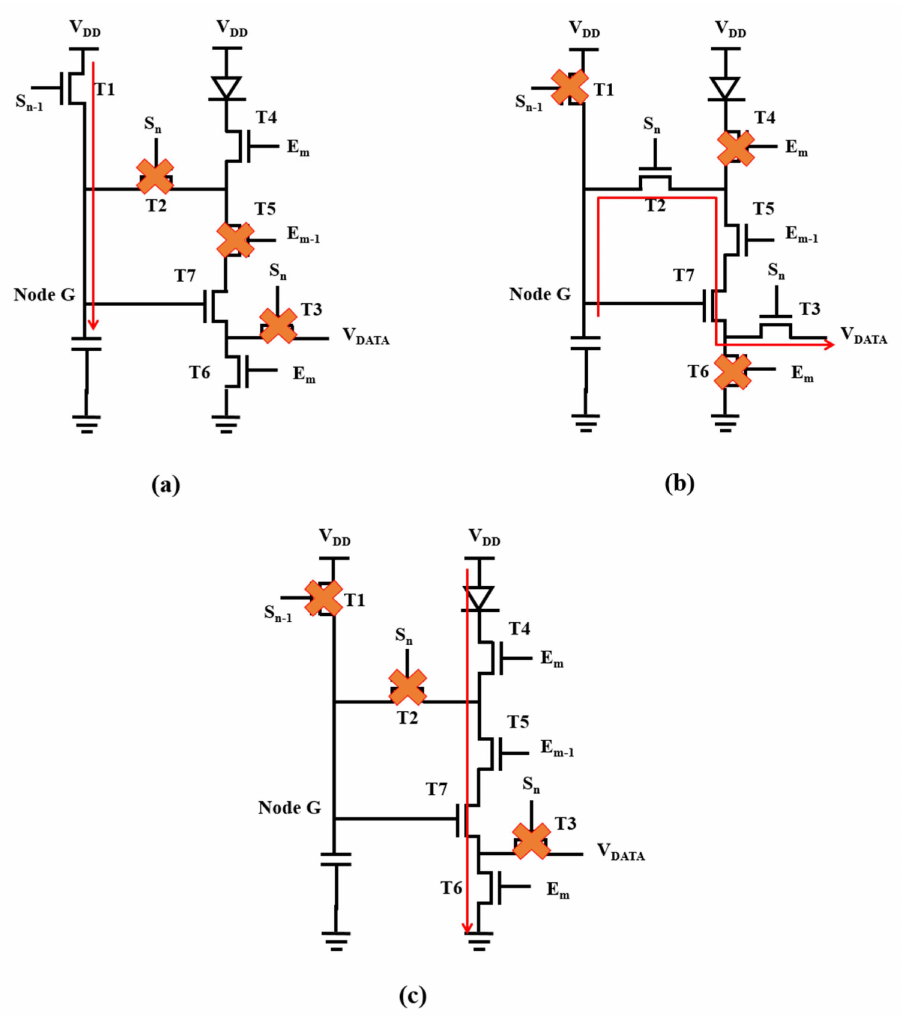
Figure 2. Schematic of circuit operation in ( a ) reset period; ( b ) programming; ( c ) emission